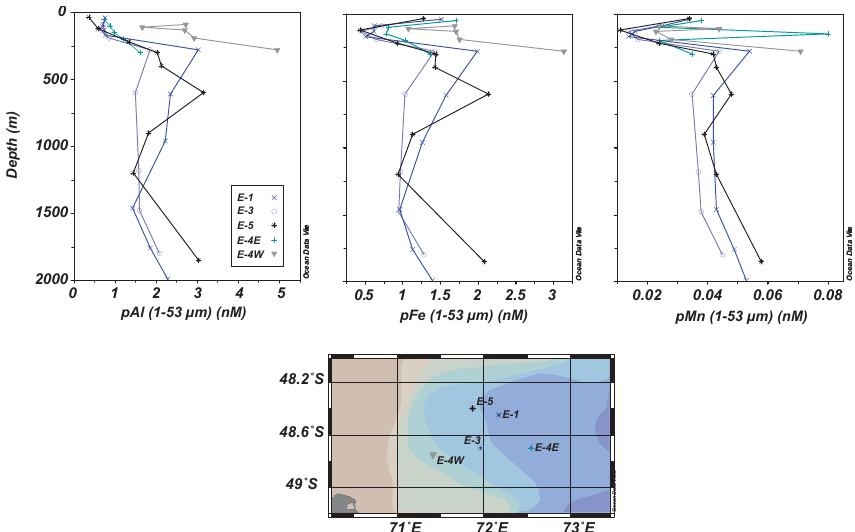
Figure 7. Profiles of particulate trace metals during the pseudo-Lagrangian recirculation-structure study. Station E-4W (gray triangle) exhibits unique trace metal profiles in comparison to the remaining stations (see text for details). Note the distinct pFe and pMn minima at 150–175m. Particulate Al exhibits a similar profile albeit without surface enrichment.